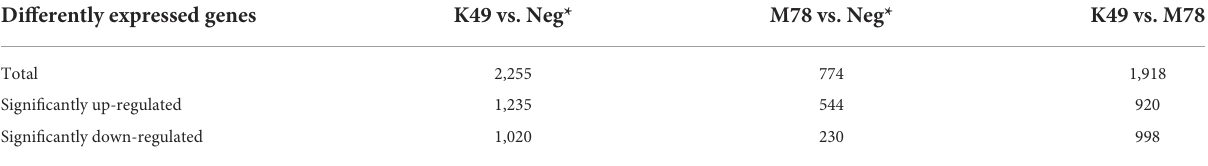
TABLE 1 The number of differently expressed genes (DEG) in PBMCs infected with ASFV strains K49 or M78 (FDR ≤ 0.05). Differently expressed